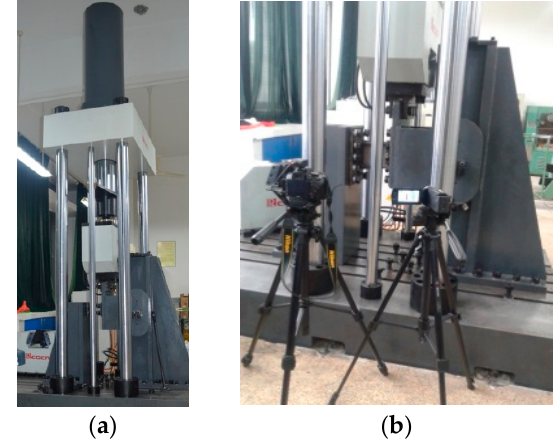
Figure 3. Machine for coupon and structural tests: ( a ) Before test; and ( b ) During test.